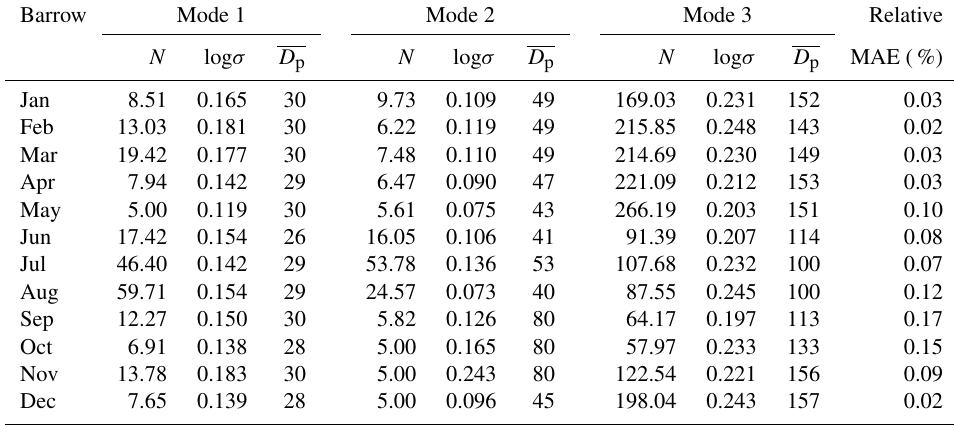
Table A2. Same as Table A1 but for Barrow.